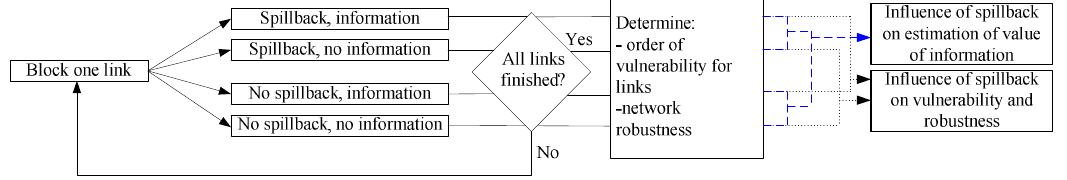
Figure 1. Outline of the research